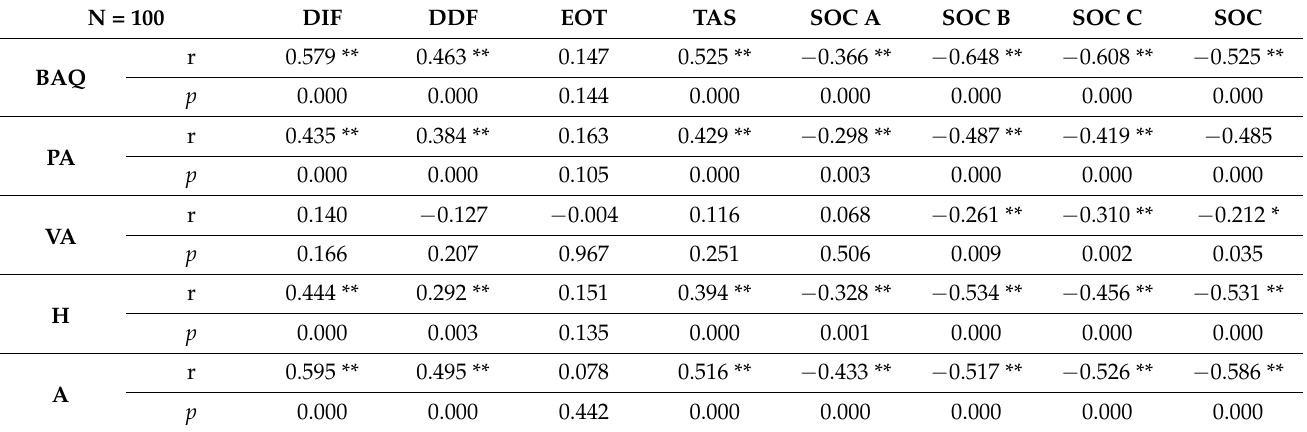
Table 3. Correlations among subscales of TAS, BAQ and